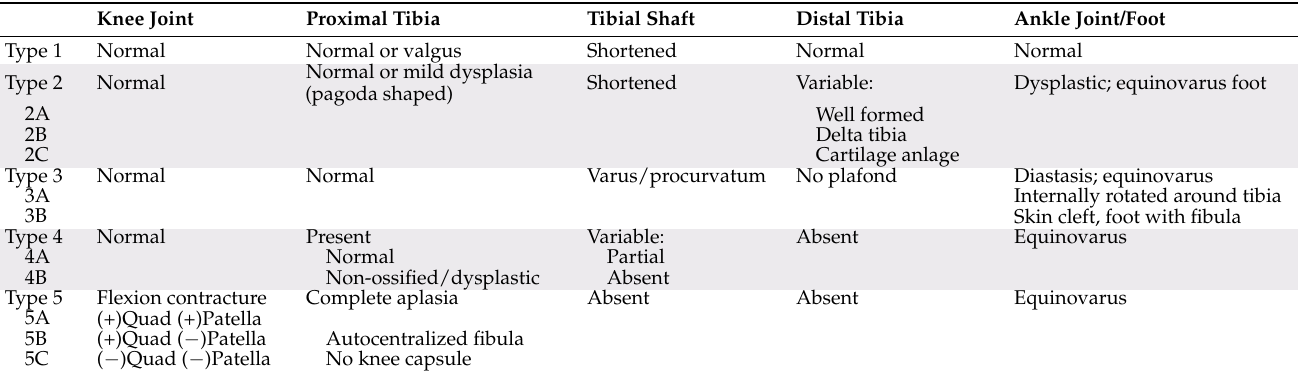
Figure 1. Jones classification of tibial hemimelia. Table 1. Paley classification of tibial